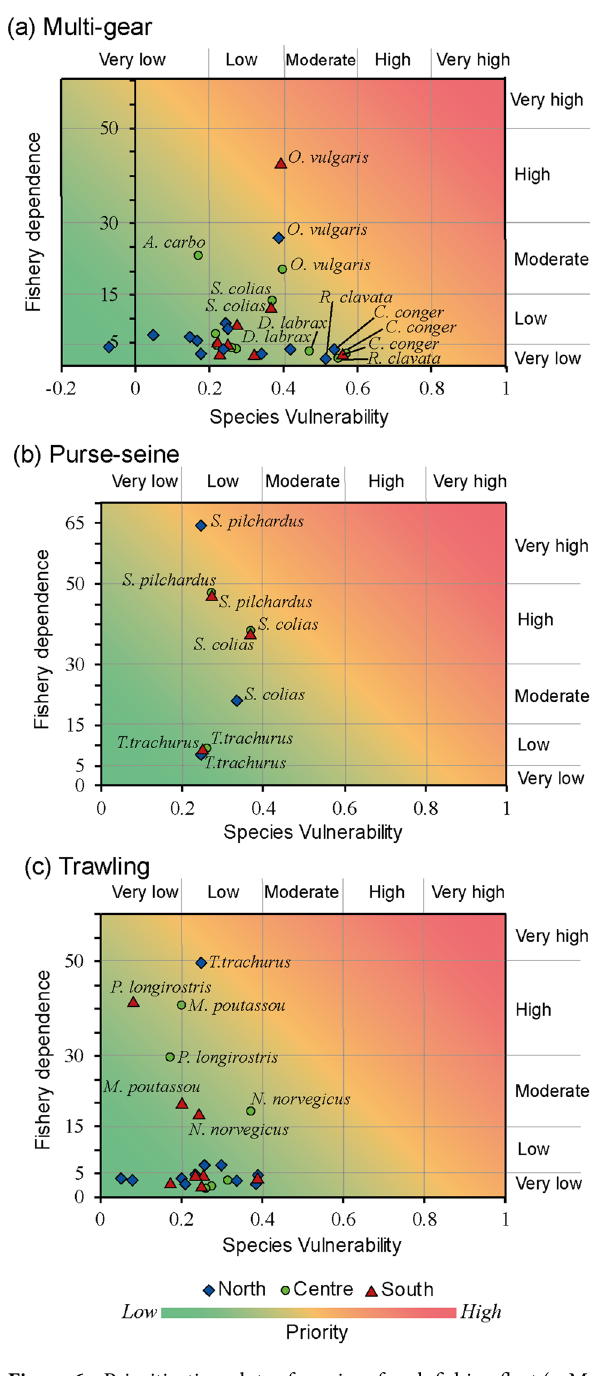
Figure 6. Prioritization plots of species of each fishing fleet ( a -Multi-gear; b -Purse-seine; c -Trawling) and area (North-red; Centre-blue; South-green), considering the main species contributing to the total ecological vulnerability for the RCP 8.5 scenario ( x axis) and considering the fisheries dependence on the species ( y axis; average contribution of landings weight and landing economic revenue). These type of plots are adapted from 7 . Only species that contributed to the total vulnerability of the fisheries landings weights or revenues in more than 3% are plotted and only species with higher priority are labelled. See tables of Supporting Information S7, S8 and S9 for a full list of species and classification. Green colour represents low prioritization values and red high